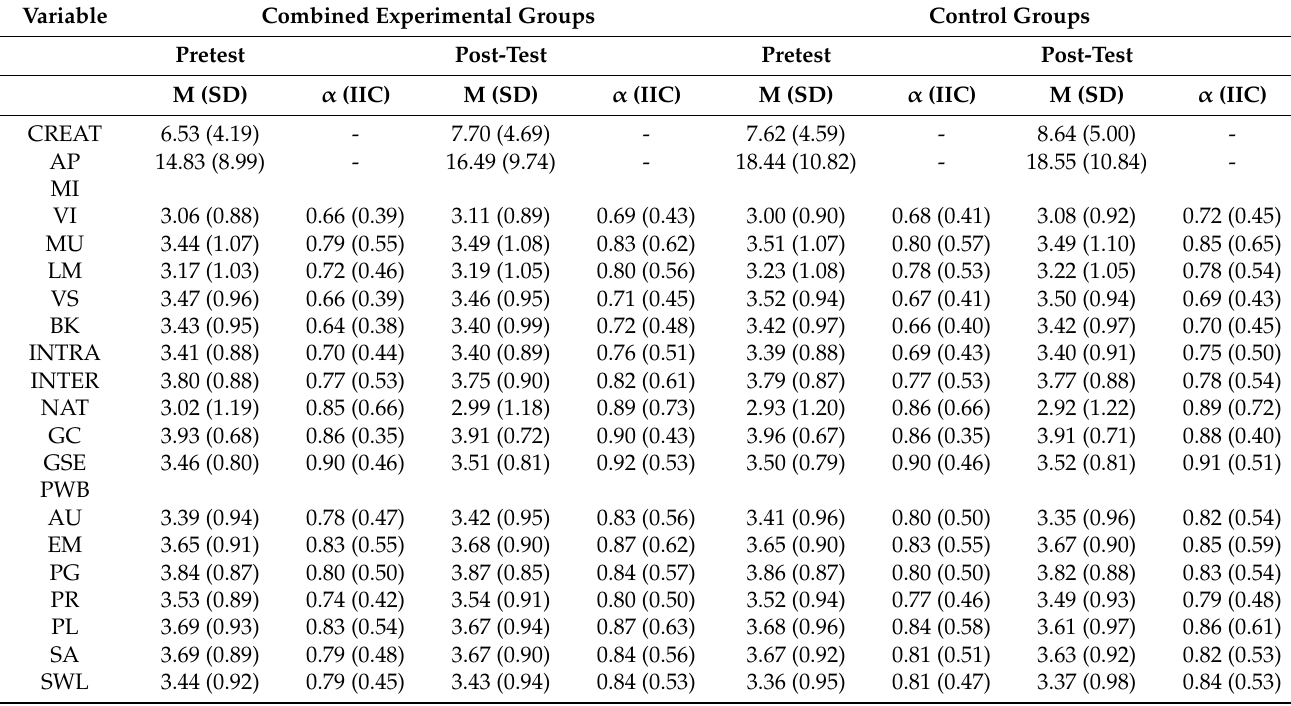
Table 4. Descriptive statistics and reliabilities of all outcome variables in the combined experimental groups and the control